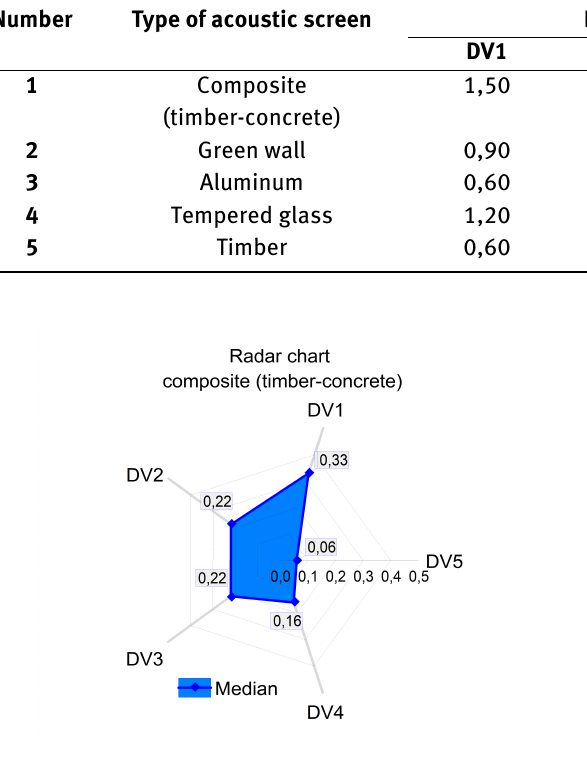
Figure 1: Radar chart for timber-concrete screen.